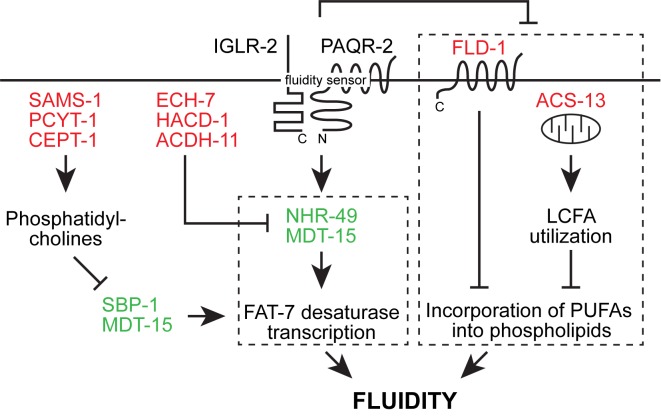
Revised model of the likely epigenetic interactions in the paqr-2 pathway based on previously published work and the present study.Loss-of-function mutation in the red-colored proteins and gain-of-function mutations in the green-colored proteins act as paqr-2 mutant suppressors. Note that there are likely two separate fluidity-promoting outputs of PAQR-2 signaling (dashed boxes): one output promotes desaturase transcription while the other output regulates incorporation of PUFAs into phospholipids. Previous studies showed that many paqr-2 suppressor mutations act by promoting desaturase upregulation, either via either SBP-1::MDT-15 or NHR-49::MDT-15 (Svensk et al., 2013; Svensk et al., 2016a; Bodhicharla et al., 2018; Ruiz et al., 2018). Loss-of-function alleles of fld-1 (Ruiz et al., 2018) and or acs-13 (present work) have so far been identified as paqr-2 mutant suppressors that act as regulators of PUFA levels in phospholipids.